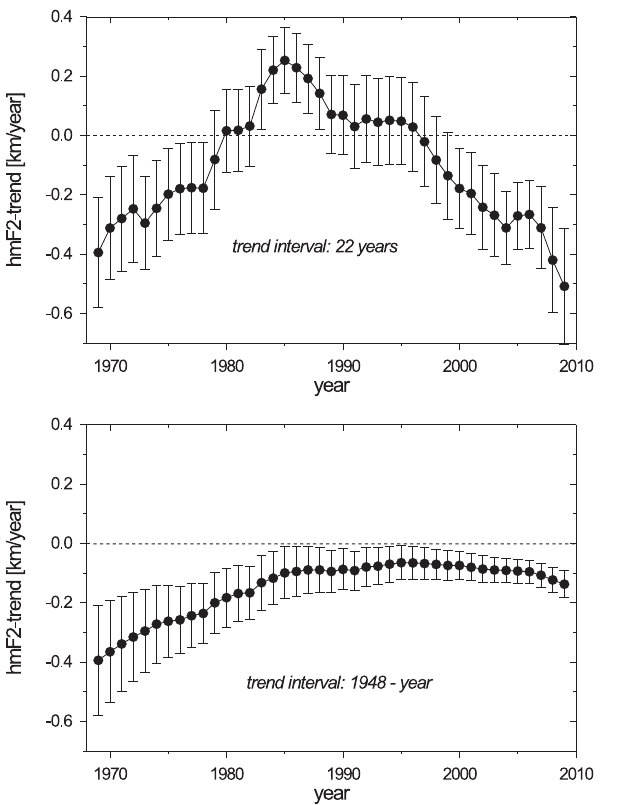
Fig. 11. Global mean fo F2 trends with error bars for constant in- tervals of 22 years continuously shifted by one year (upper part) and for intervals with increasing data length (lower part). The trend values are drawn in both cases at the upper end of the intervals in-